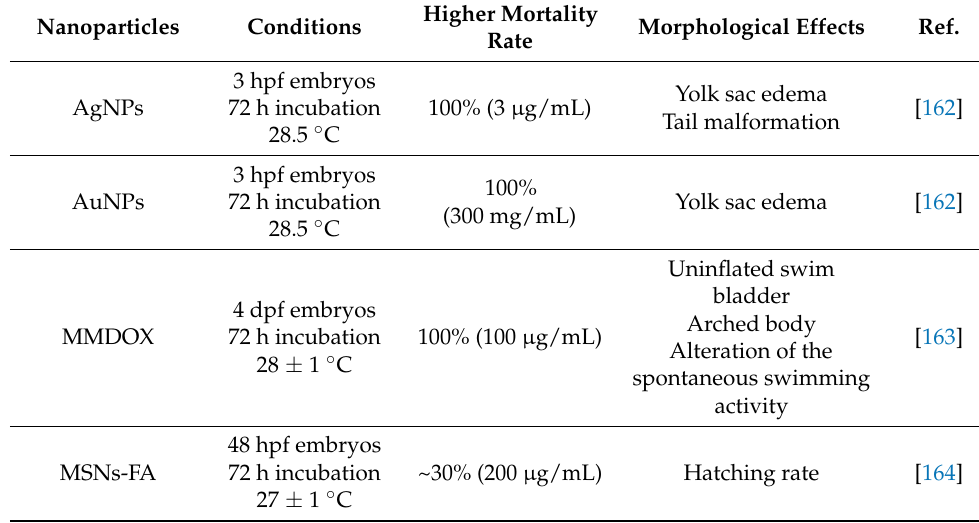
Table 2. Zebrafish-based toxicity studies of different nanoparticles for cancer